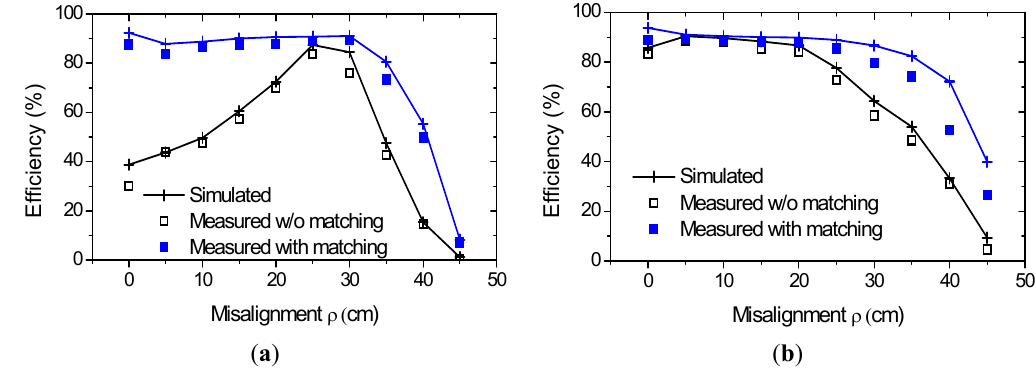
Figure 16. Efficiency comparison for different lateral misalignments at two distances: ( a ) d = 15 cm; and ( b ) d = 30 cm.